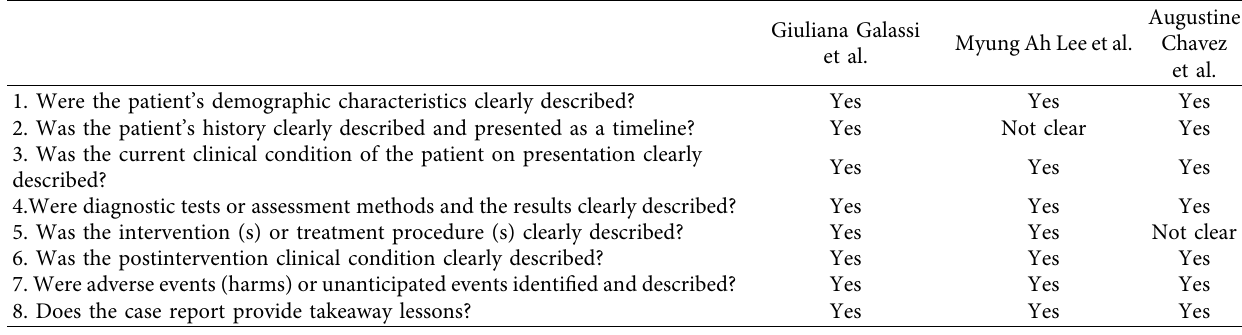
Table 2: Quality assessment based on the JBI tool for case reports.